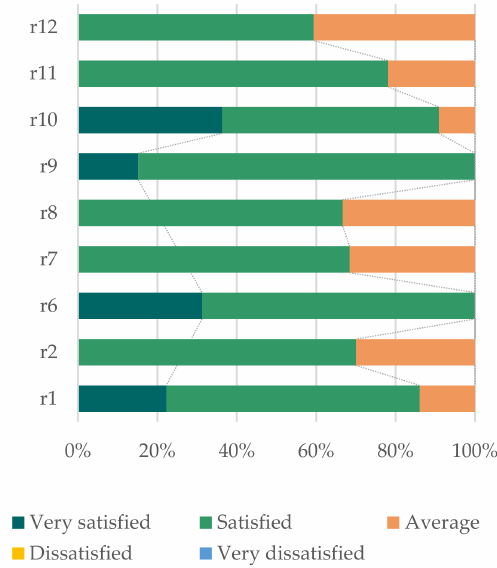
Figure A14. User satisfaction in Renmin Park.